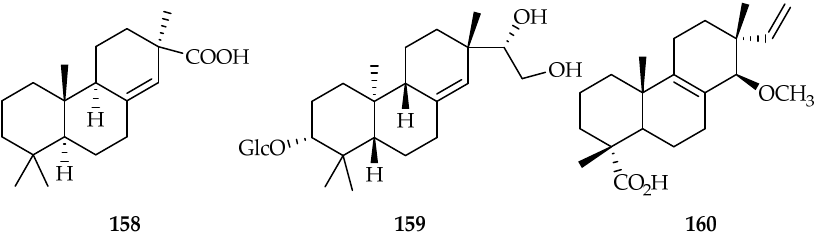
Figure 66. Structures of agalong C 158 [99], siegeside B 159 [103], and euonymusisopimaric acid B 160 [104].